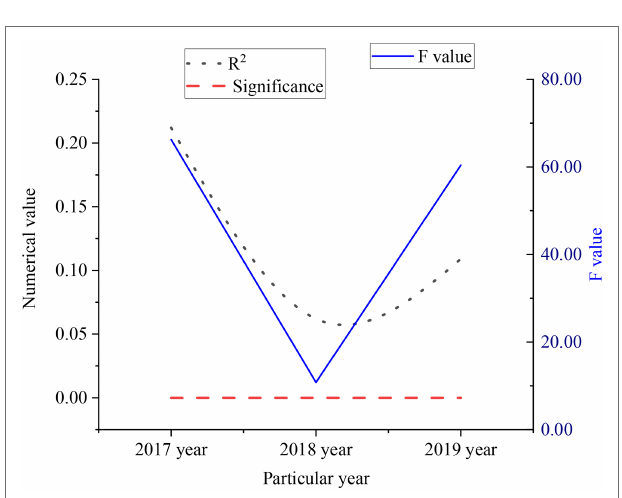
FIGURE 11 | Linear regression data of